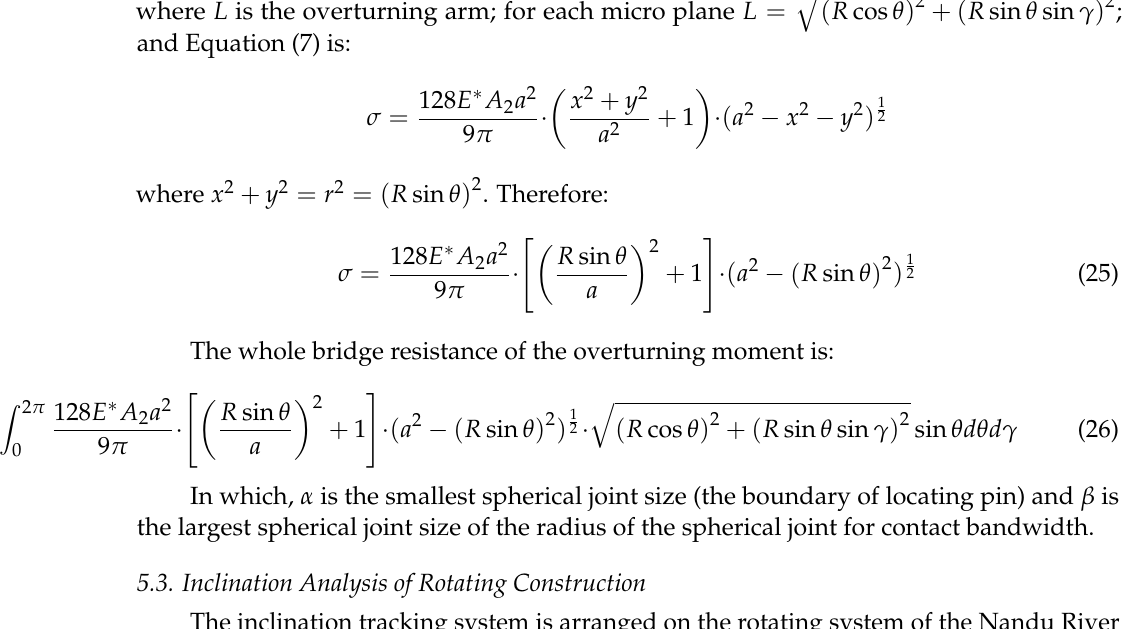
Table 3. Factors of the rotating system. Factors Frictional Coefficient µ The Height of Gravity